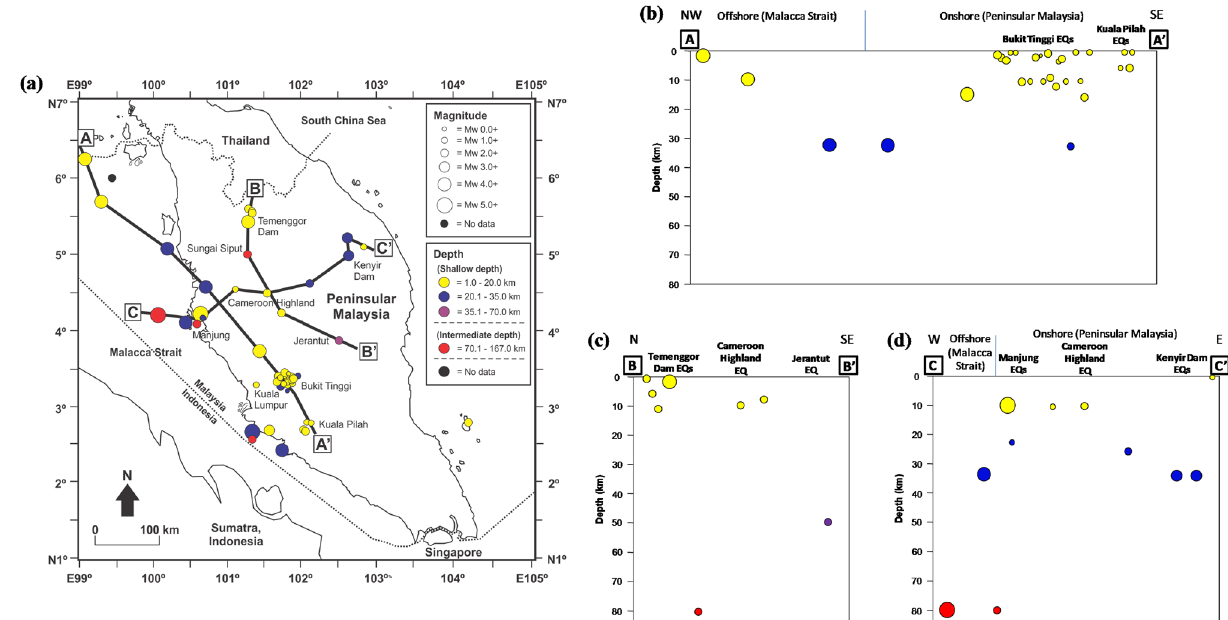
trend NW–SE. c Depth profile B–B ′ with the trend N–S–SE; and d depth profile C–C ′ with the trend W–E. Note: Created with Corel-